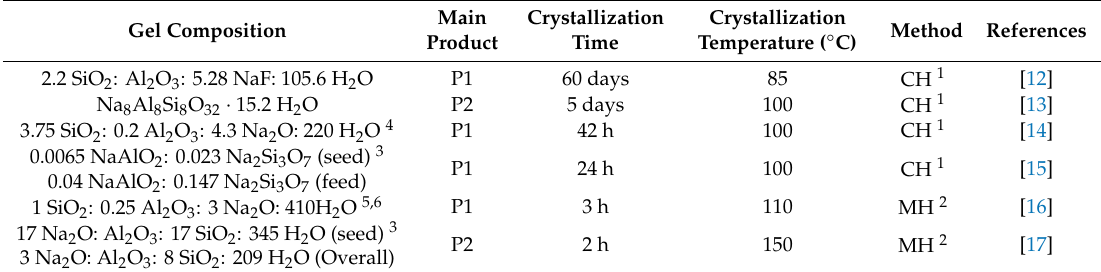
Table 1. Gel composition and synthesis parameters of zeolite P from the literature. Main Gel Composition